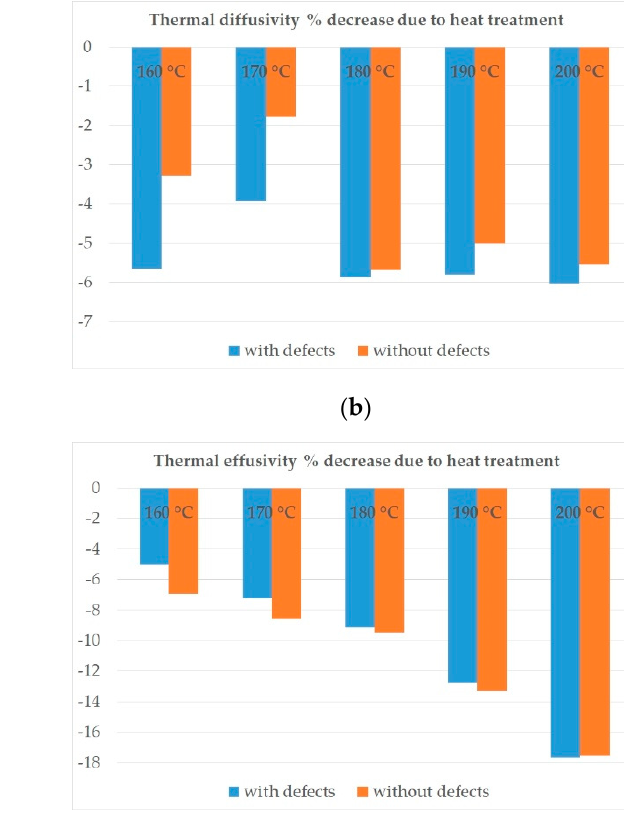
Figure 7. Graphic visualization of the effect of heat treatment temperature to percentage changes of ( a ) thermal conductivity, ( b ) thermal diffusivity, ( c ) volume heat capacity, and ( d ) thermal effusivity.